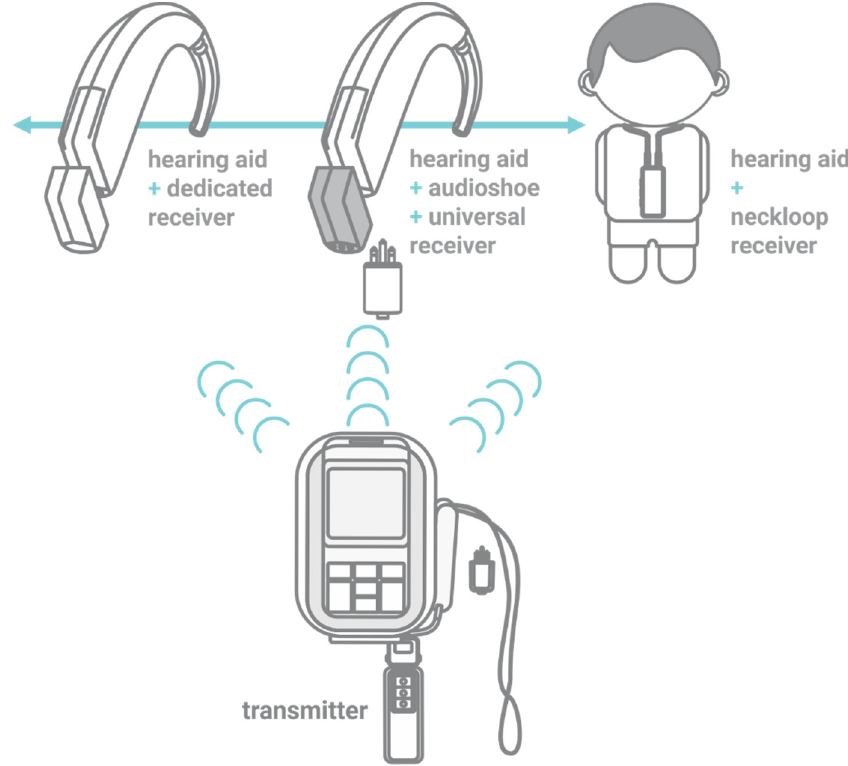
Figure 1. Remote microphone system: Transmitter and three types of receivers—dedicated, universal and neckloop.